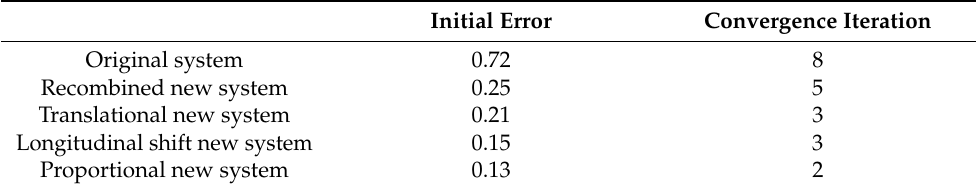
Table 4. Effect of Experience Transfer for PD-ILC.